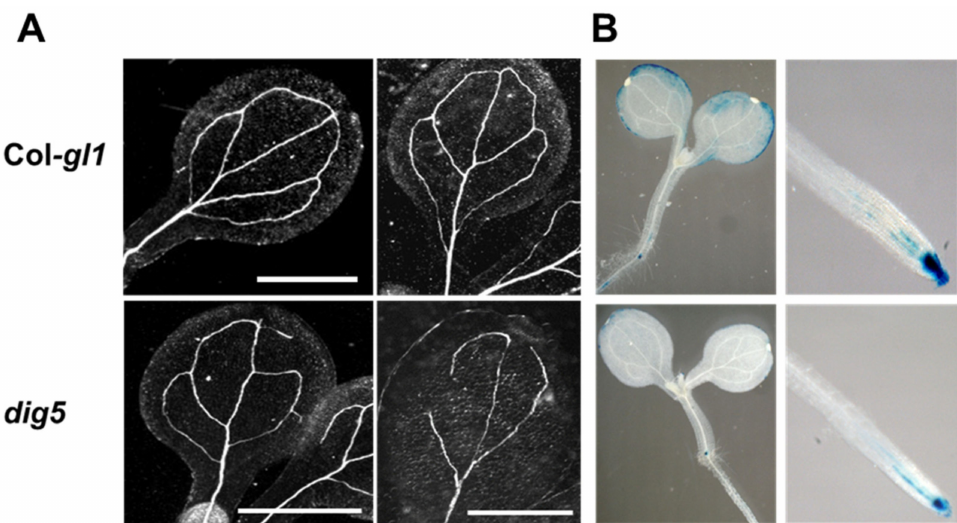
Figure 3. Leaf venation defects and reduced auxin levels in dig5 mutant seedlings. ( A ) Representative pictures of leaf venation in seedlings of wild type (Col- gl1 ) and dig5 mutant. Scale bars = 1 cm. ( B ) Expression of DR5-GUS reporter gene (GUS-staining) in wild type (Col- gl1 ) and dig5